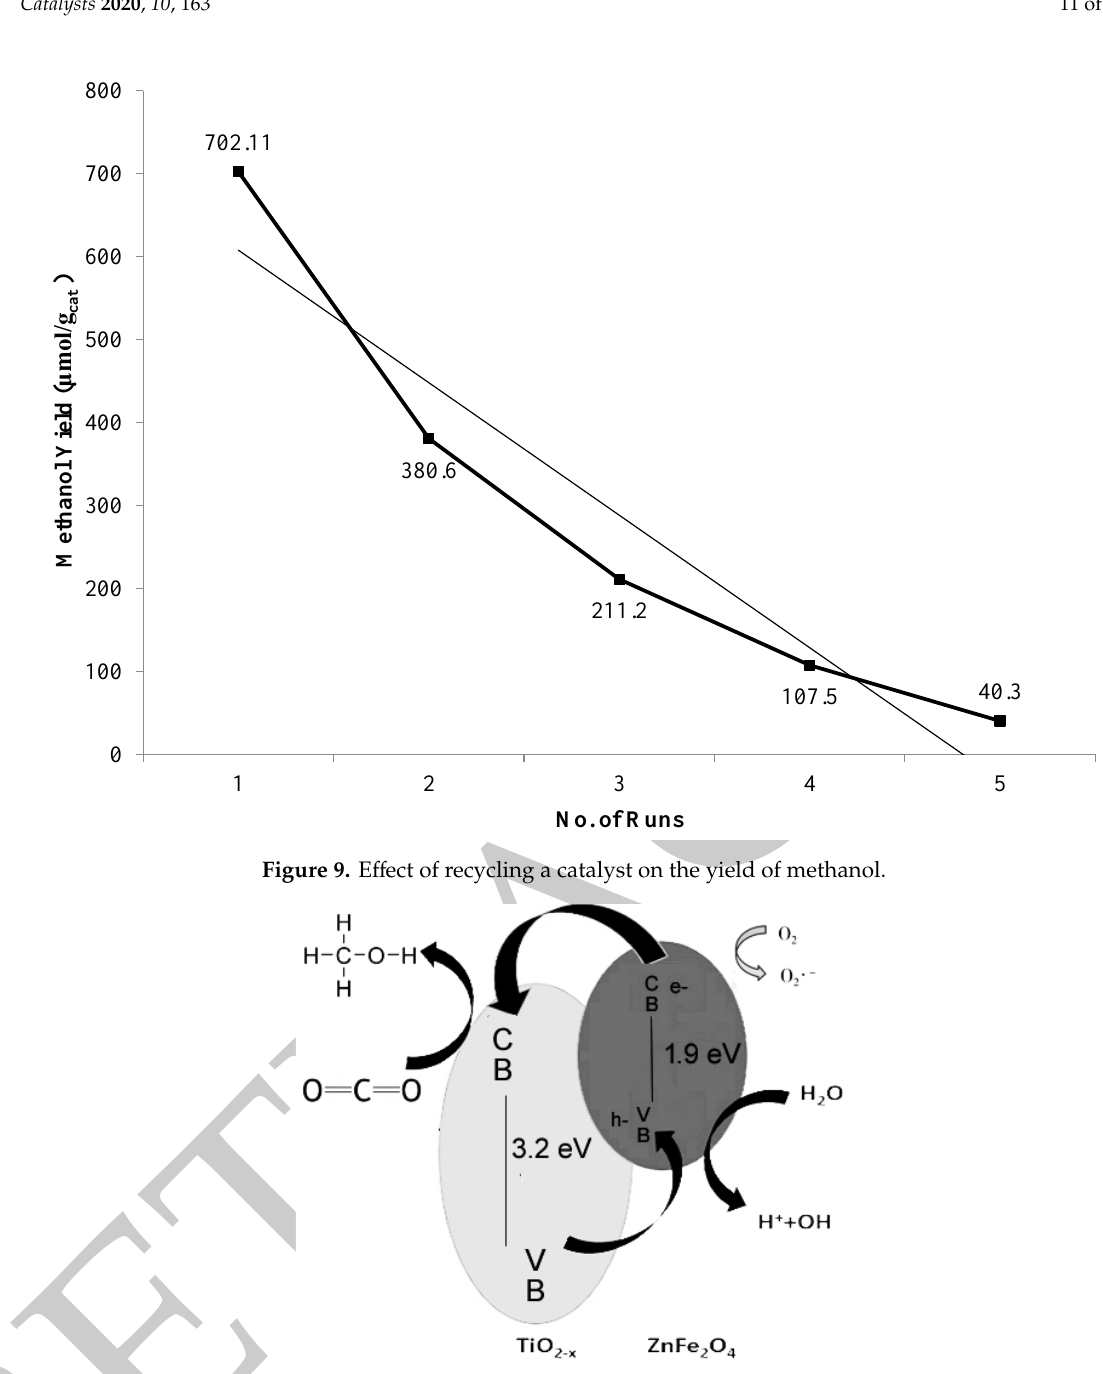
Figure 10. Proposed reaction mechanism.